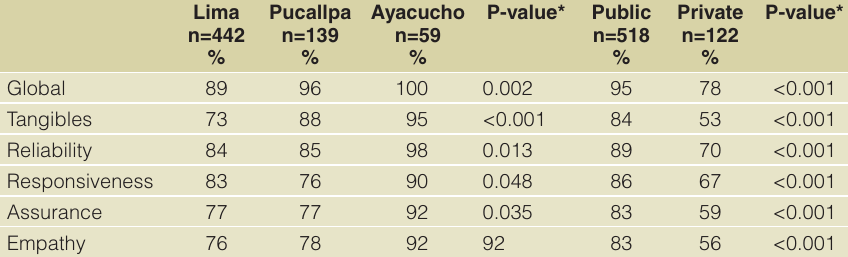
Table 3. Proportion of dissatisfaction, score for each of the domains, both individual and global scores, listed in the modified Service Quality questionnaire by city and health care facility type.